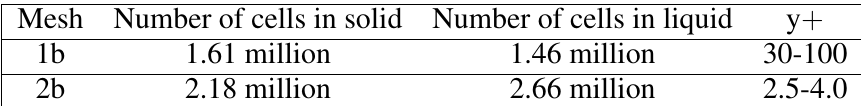
Table 2: Information regarding the number of cells and y + for the meshes used in STAR-CCM+ models.